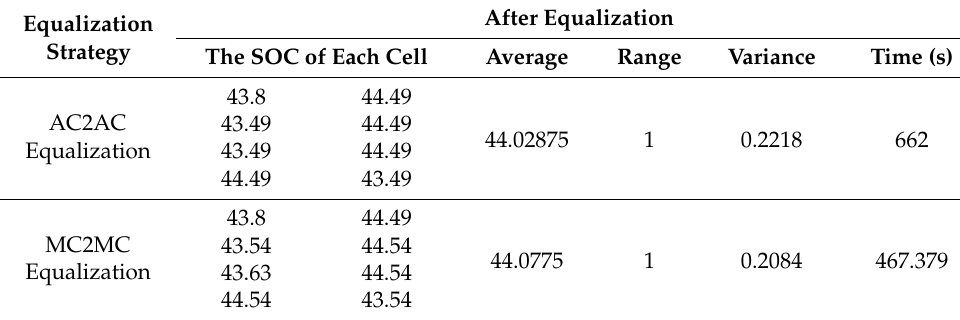
Table 4. Equalization results for AC2AC and MC2MC control